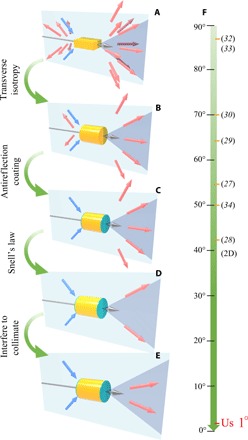
Illustration of the series of mechanisms applied, in turn, to achieve the OPF.The yellow particle is illuminated by a transversely isotropic Bessel beam, which propagates in the direction of the gray arrow, and its constituting k vectors lie on the cone formed by the revolution of the blue arrows about the partial axis. The green layer represents the ARC, and the semitransparent black cone is the pulling cone. In (A), the scattered fields are represented by the pink arrows. In (B) to (E), the scattered fields are represented by the cone formed by the revolution of the red arrows about the partial axis. (A) Scattering by a general particle. Light is scattered everywhere. (B) Introducing transverse isotropy to eliminate the diffraction in the azimuthal direction. (C) Introducing ARC to eliminate reflection. (D) Snell’s law approximately aligns the scattered field to the edge of the pulling cone. (E) The diffracted light is collimated by the interference. (F) Half-cone angles achieved in the literature.